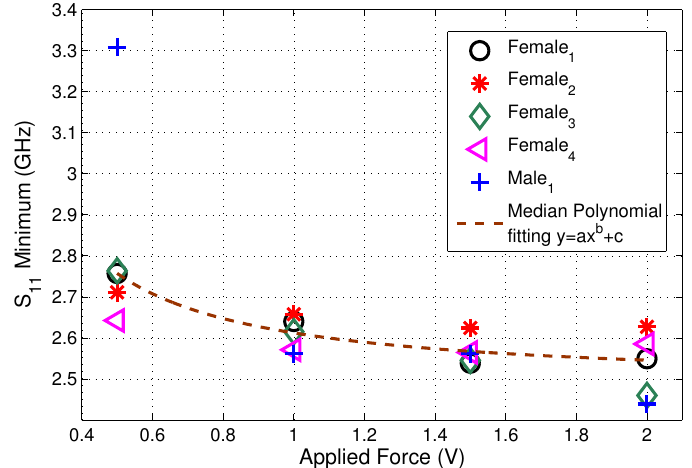
Figure 9. Change in sensor S 11 response with the applied force voltage output.